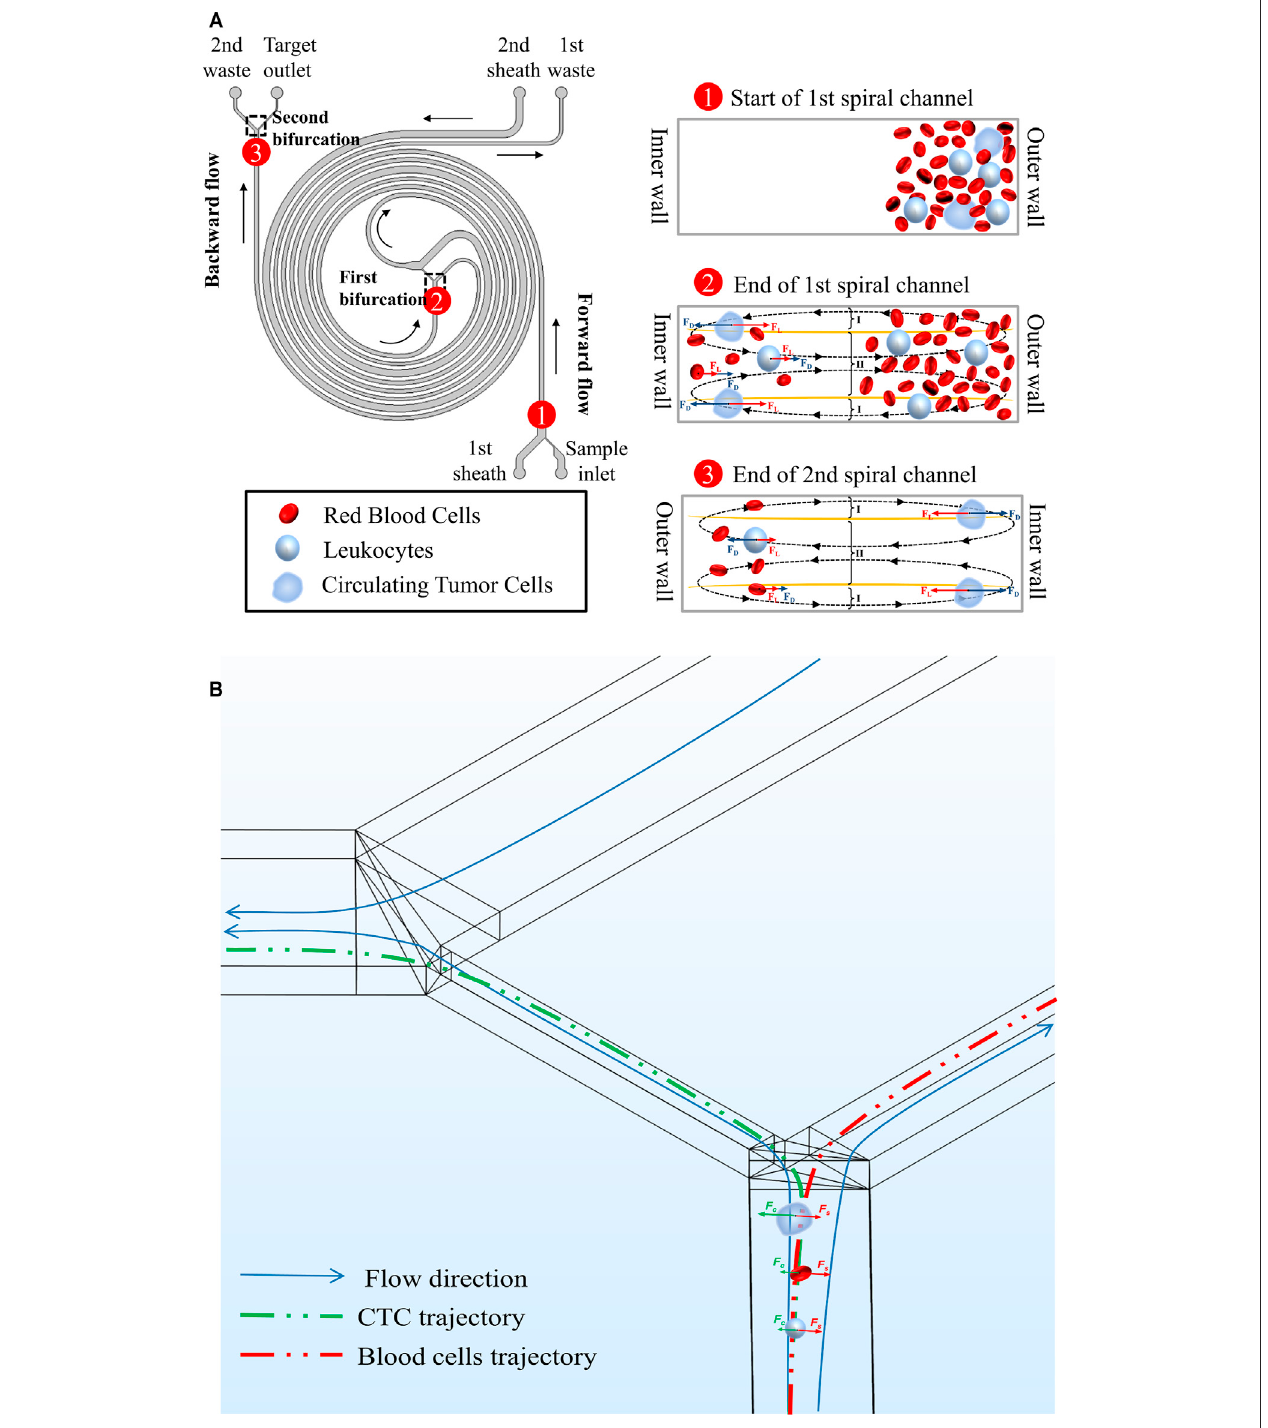
FIGURE 1 | Schematic illustrations and working principles of cell focusing in the double spiral microchannel. (A) The working principle of the rectangular cross- section double spiral microchannel to separate CTCs. The de fi ned names of all inlets and outlets were marked in the diagram. Morphologically different cells moved toward different equilibrium positions. Black arrows indicated the fl ow direction of the fl uid. (B) Affected by soft inertia, various sized cells were de fl ected into different outlets at the 1st bifurcation. Green and red arrows showed the migrated direction of CTCs and blood cells.